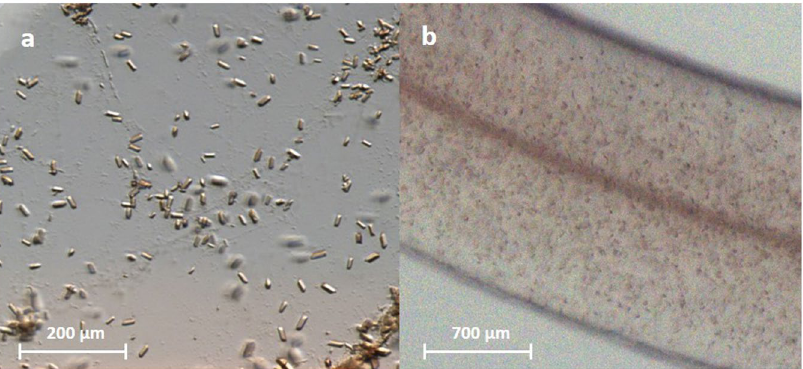
Figure 1. Microcrystals of ba 3 C c O. ( a ) Microcrystals in an LCP drop. ( b ) Microcrystals in a string of